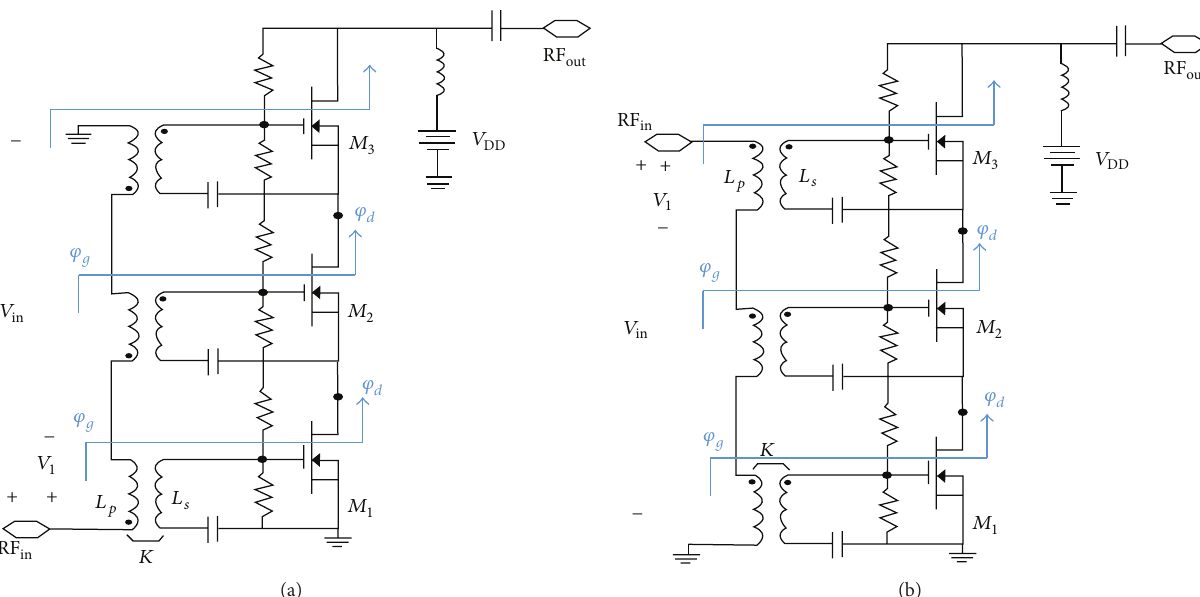
Figure 6: Two kinds of transformer orientations of stack PA. In (a), the transformers are opposite coupled. (b) The upside-down input fed configuration